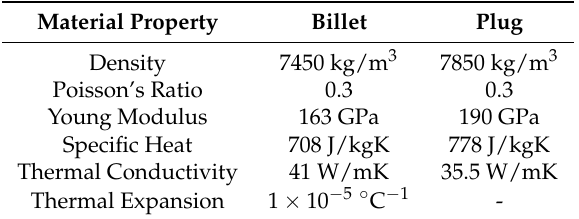
Table 3. Thermal and mechanical material properties, data from